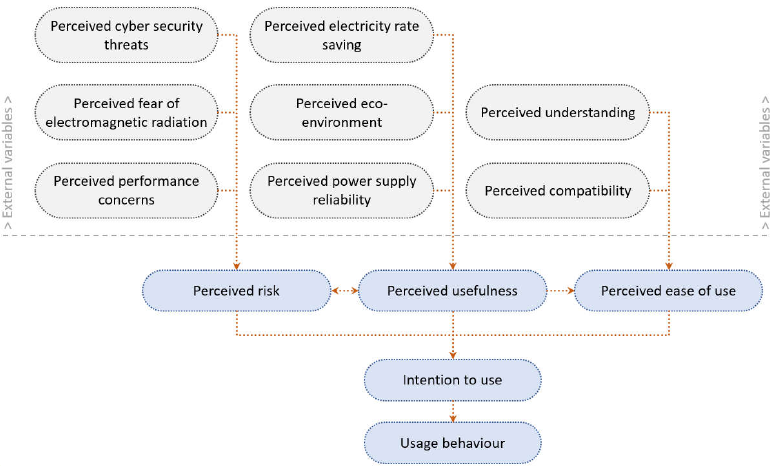
Energies 2023 , 16 , 270 Figure 1. Acceptance model proposed by Ellabban and Abu-Rub (2016) [57]. Figure 1. Acceptance model proposed by Ellabban and Abu-Rub (2016) [57].